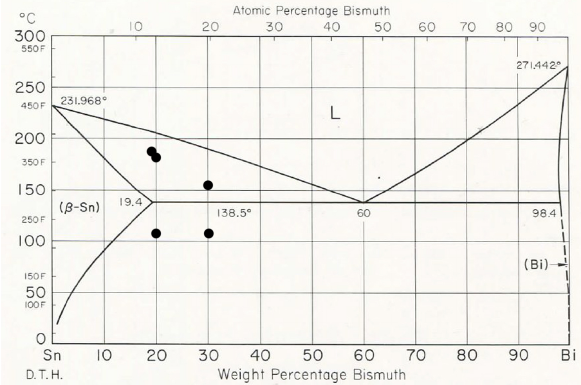
Figure 7: Bi-Sn phase diagram [21] with experimental points (from the left) 7 and 8, Table 1.